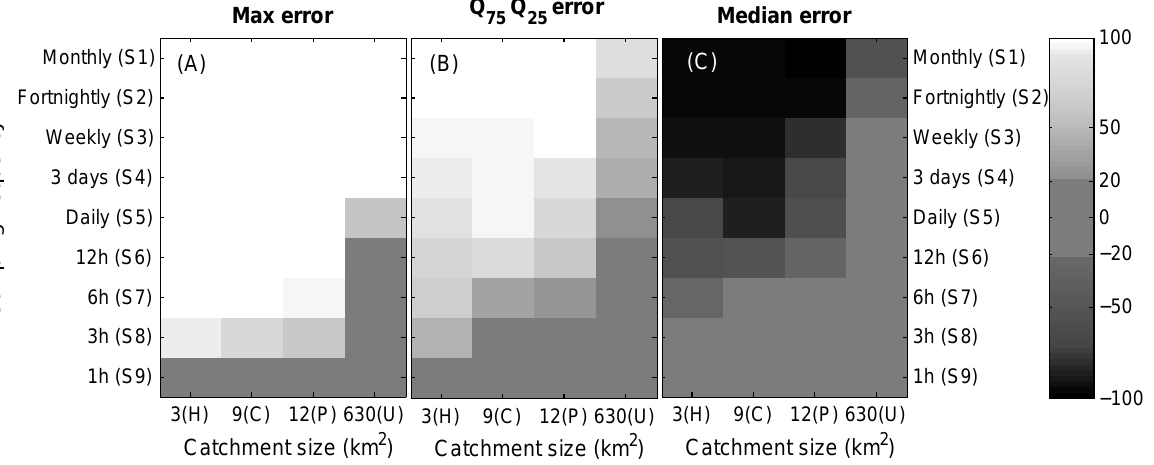
Fig. 4. Influence of the sampling frequency on SSY estimates depending on various strategies (from 1 sample per month, S1, to 1 sample per hour, S9), at each station. The degree of error on SSY estimates was represented by a grey-scale gradation: white cells correspond to a 100% positive bias whereas black cells correspond to a 100% negative bias. Marked grey cells represent values belonging to the ± 20% range. (a) Maximum errors. (b) Highest quartile errors. (c) Median errors.